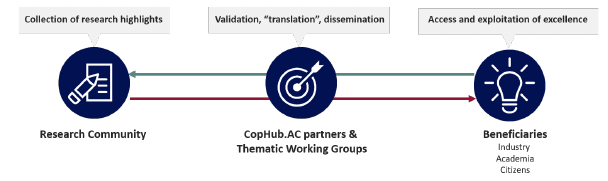
Figure 2. Innovation